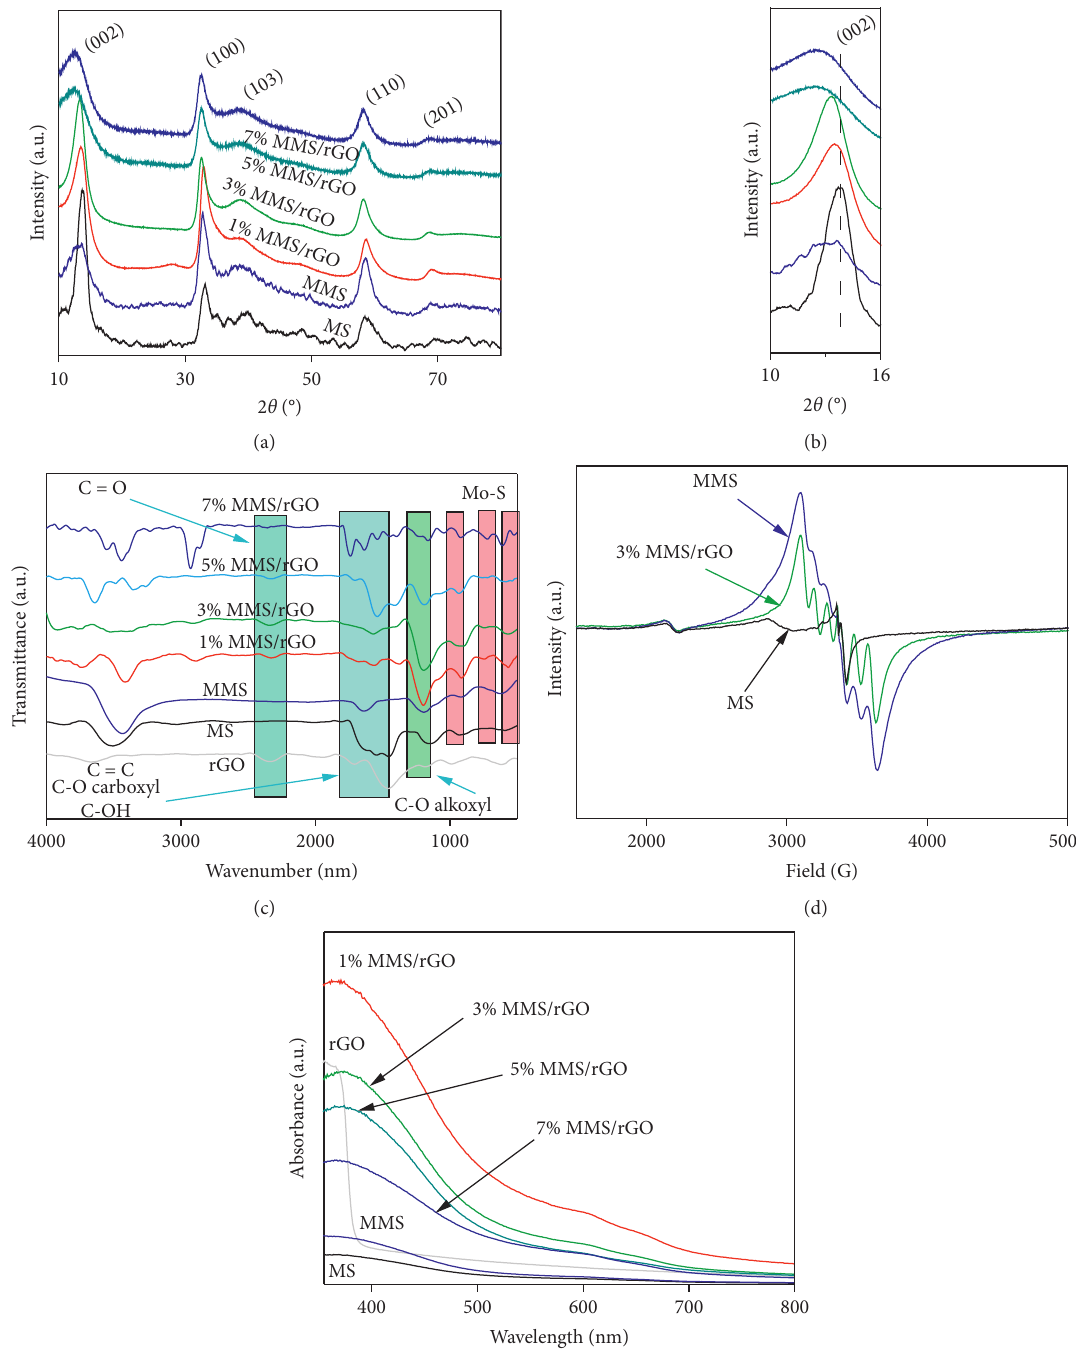
Figure 1: (a) XRD patterns; (b) XRD patterns with enlargement of (002) peak; (c) FTIR; (e) UV-Vis spectra of MS, MMS, and n %MMS/rGO composites; (d) EPR spectra of MS, MMS, and